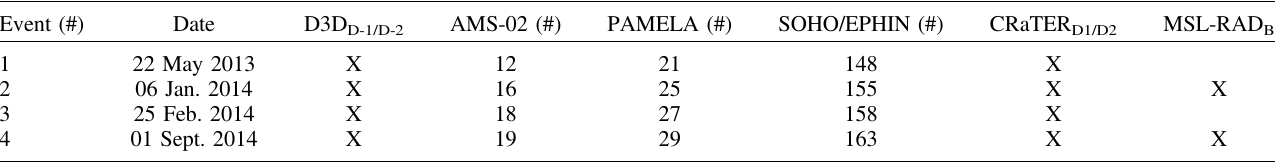
Table 4. Newly identi fi ed SPE events seen with the D3D D-1/D-2 instruments on board the ISS. These events have also been measured by AMS- 02, PAMELA, SOHO/EPHIN and CRaTER D1/D2 as well as (for two events) with MSL-RAD B . Event (#)